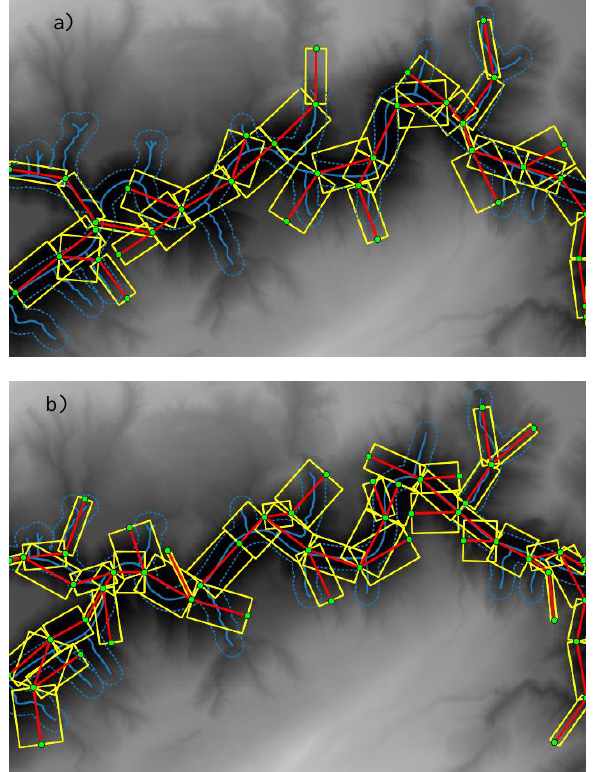
Figure 12. Results for the test site in Austria using (a) all prior terms and (b) by excluding the prior term for the flow direction ( p f = 0). Blue solid lines: reference data of the medial axes of the river network, blue dotted line: puffer for